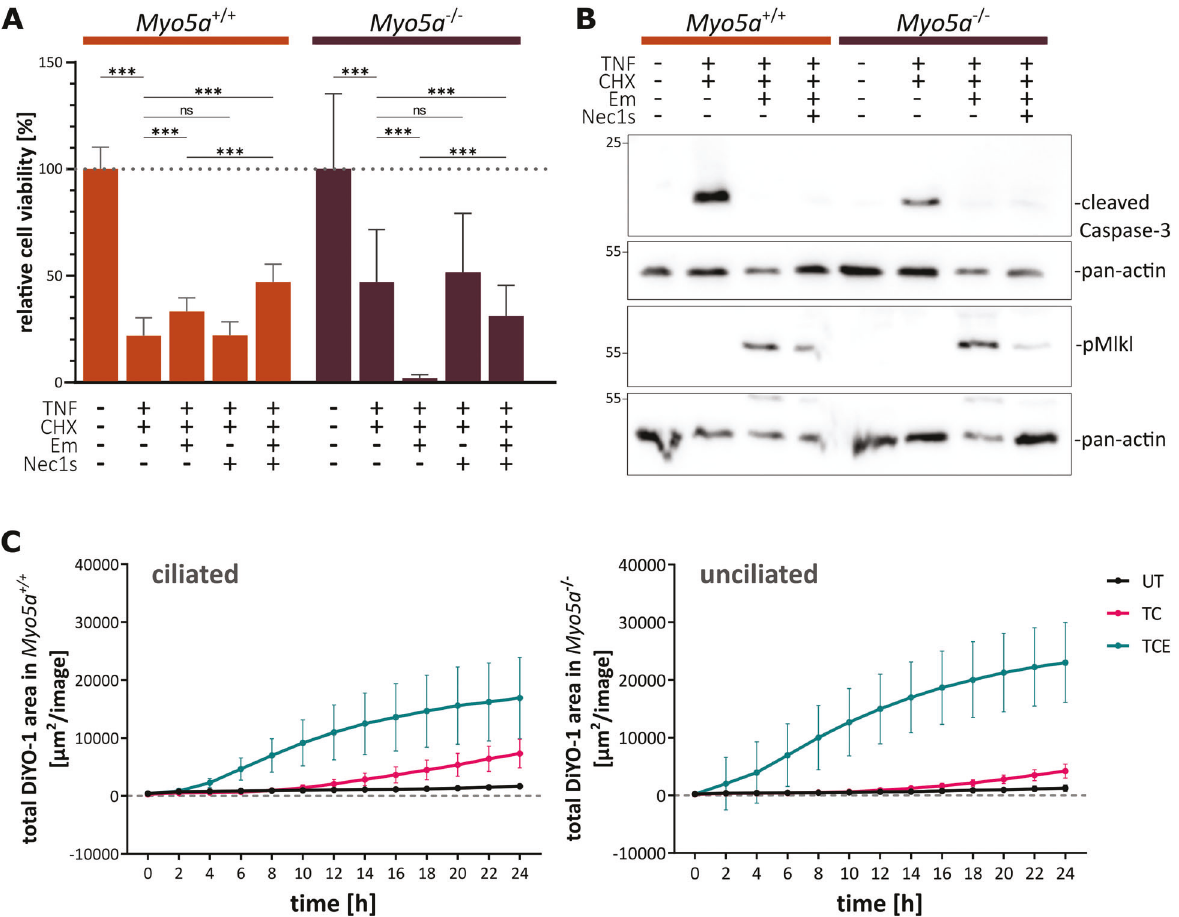
Fig. 2 Loss of cilia in Myo5a-de fi cient cells increases susceptibility to necroptotic death. A Neutral-red assay in control and Myo5a − / − cells after RCD induction through TNF α (TNF, 4 ng/100 µl) and cycloheximide (CHX, 2 µg/100 µl) for 16 h. Additionally, caspase-8 inhibitor emricasan (Em, 10 µM) and necroptosis inhibitor necrostatin-1s (Nec1s, 40 µM) were used for 16 h ( n = 4). B Immunoblot analysis of ciliated and non- ciliated cells using the apoptosis marker cleaved caspase 3 (~17 kDa) and the necroptosis marker phospho-Mlkl (~56 kDa). As housekeeping control either pan-actin (~30 kDa) or beta-tubulin (~55 kDa) were used ( n = 3). C Live-cell imaging over the period of 24 h after treatment with TNF and CHX (TC), and TNF, CHX, and Em (TCE) or DMSO as control. Cells were stained with the dead cell marker DiYO-1. Images were captured every 2 h ( N = 8).